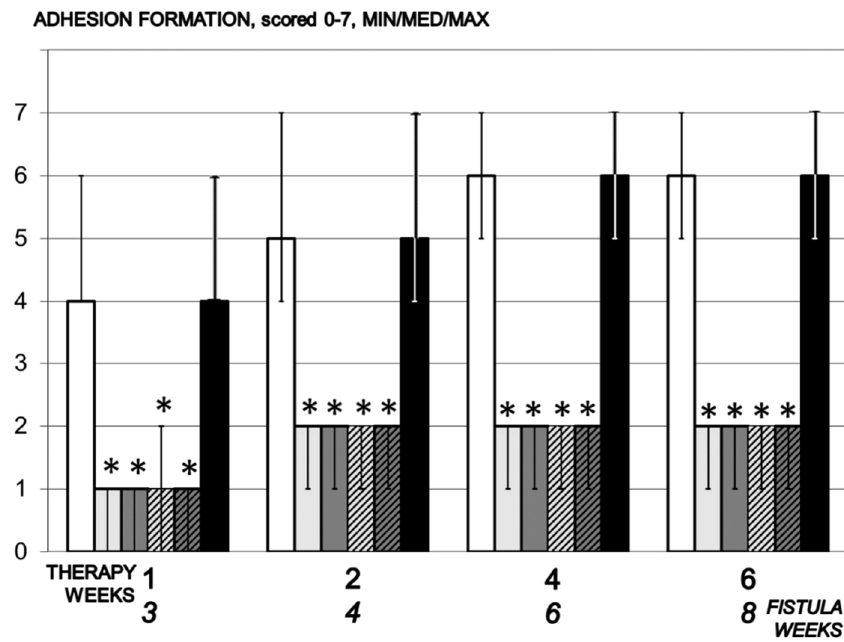
Figure 3. Adhesion formation, scored 0–7, Min/Med/Max, time line. Therapy regimens starting at the day 14 after fistula creation (therapy day 0), included BPC 157 given once daily intraperitoneally, last application at 24 h before sacrifice, 10 µ g/kg (light gray bars) or 10 ng/kg (dark gray bars) or given perorally, in drinking water 10 µ g/kg/day (dashed light gray bars) or 10 ng/kg (dashed dark gray bars) until the sacrifice. Controls received simultaneously an equal volume of saline (5 mL/kg) intraperitoneally (white bars) or drinking water (12 mL/rat/day) (black bars). * p < 0.05, relative to